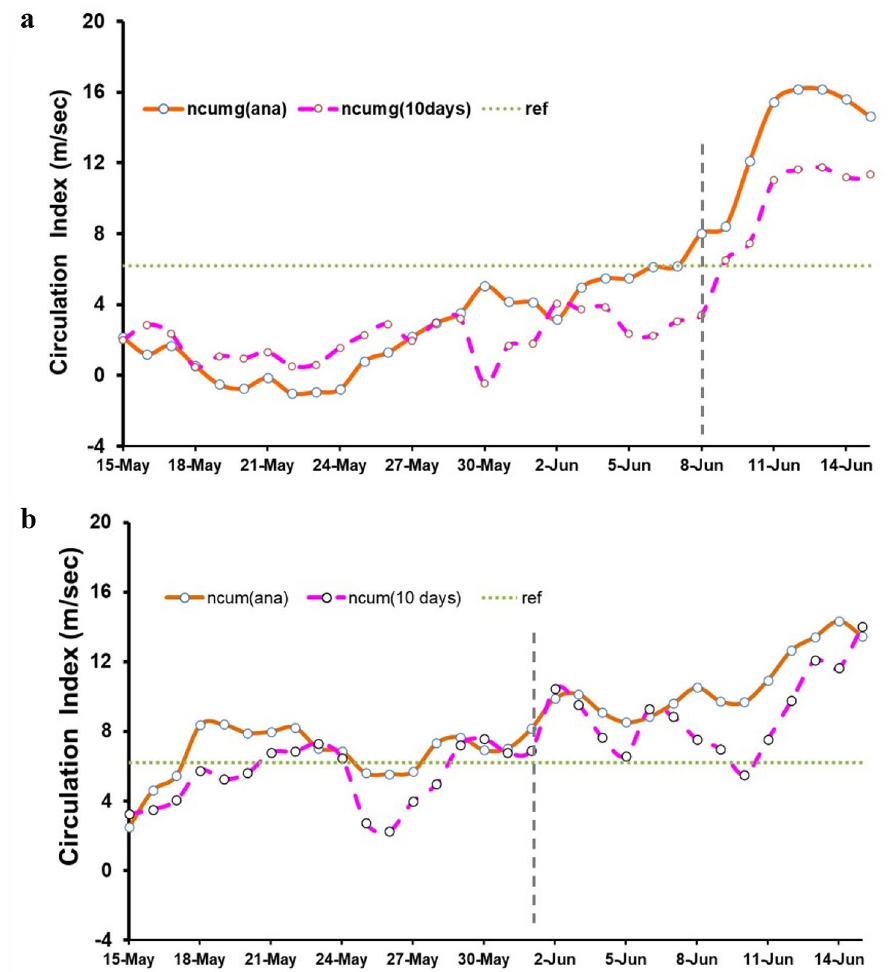
Fig. 9 Time series of daily monsoon index (m/s) a NCUM analysis, 10-day forecast valid for 15 May—15 June 2019, and b NCUM analysis, 10-day forecast valid for 15